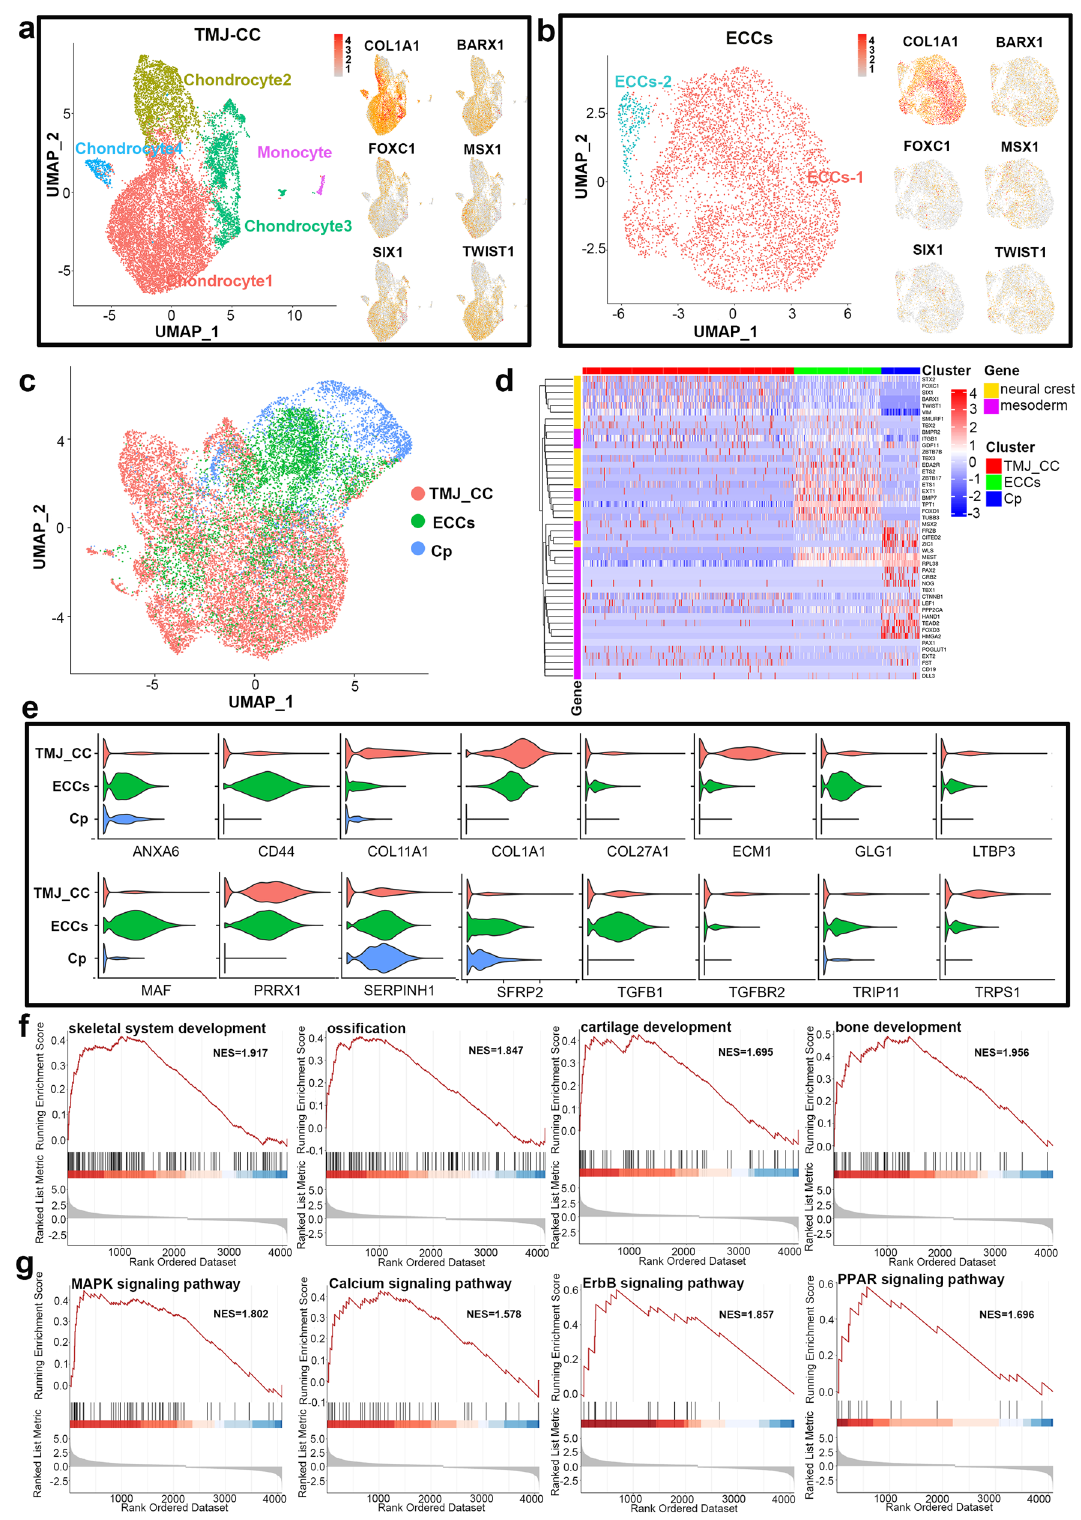
Fig. 5 ECCs have similar single-cell transcriptome pro fi les to TMJ condylar chondrocytes. a and b Both TMJ-CC and ECCs were enriched in mandibular condyle and neural crest markers, such as COL1A1, BARX1, FOXC1, MSX1, SIX1, and TWIST1. c UMAP con fi rmed that ECCs are closer to TMJ-CC than Cp from hiPSCs via the paraxial mesoderm. d Both the TMJ-CC and ECCs exhibited high expression of neural crest markers, while genes involved in mesoderm were clustered in the Cp. e Violin plots showing that TMJ-CC and ECCs presented nearly the same chondrogenic markers. f GSEA suggesting that ECCs had different gene expression from Cp in skeletal system development, ossi fi cation, cartilage development, and bone development. g MAPK, calcium, ErbB, and PPAR signalling pathway-associated genes were different between ECCs and